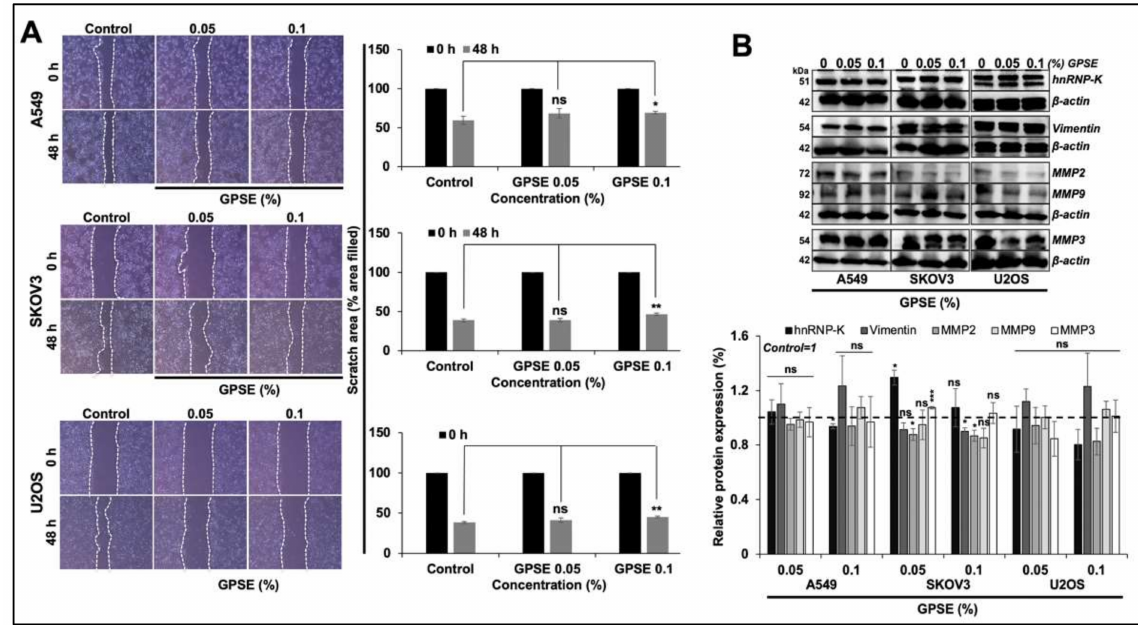
Figure 2. Low dose of GPSE did not affect the cell migration. Wound healing assay showing migration of cells in the wounded area. By 48 h and as examined in three cell lines there was no effect of GPSE ( A ). Western blotting of proteins (hnRNP-K, Vimentin, MMP2, MMP9, and MMP3) involved in cell migration did not show any change in the expression level in control and treated cells ( B ). The quantified data represents mean ± SD obtained from three independent biological replicates; p -values were calculated using unpaired Student’s t -test. * < 0.05, ** < 0.01, and *** < 0.001 represent significant, very significant, and very very significant, respectively. ns = not